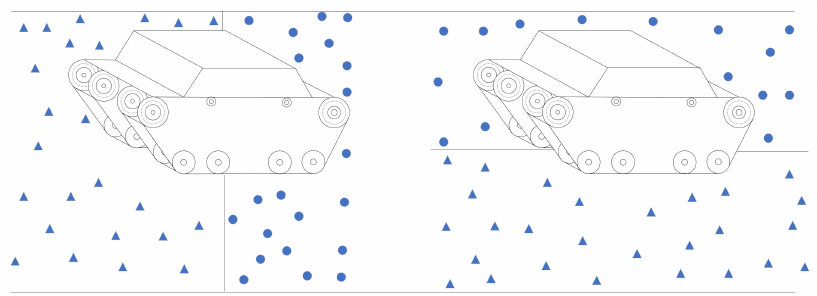
Figure 1. Joint road surfaces and mu-split road